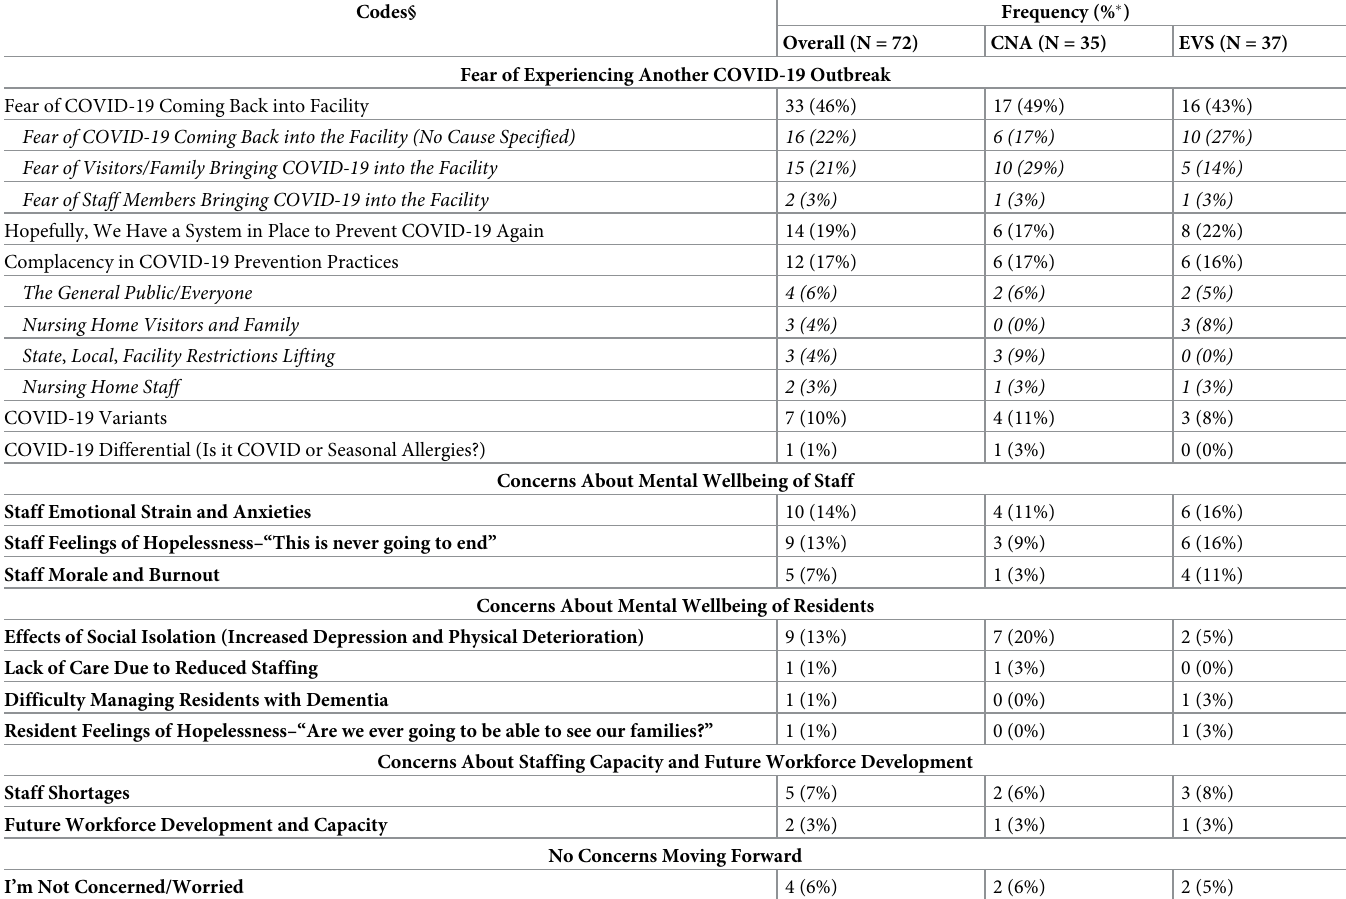
Table 6. Frequency of qualitative codes by theme: What are you most concerned about moving forward?.